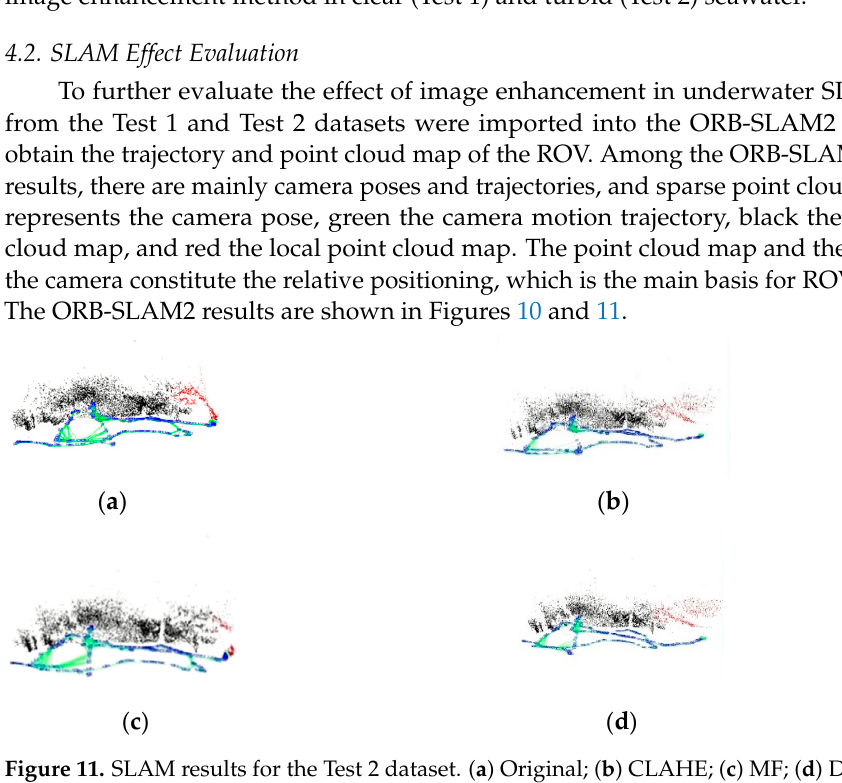
Figure 11. SLAM results for the Test 2 dataset. ( a ) Original; ( b ) CLAHE; ( c ) MF; ( d ) DCP.